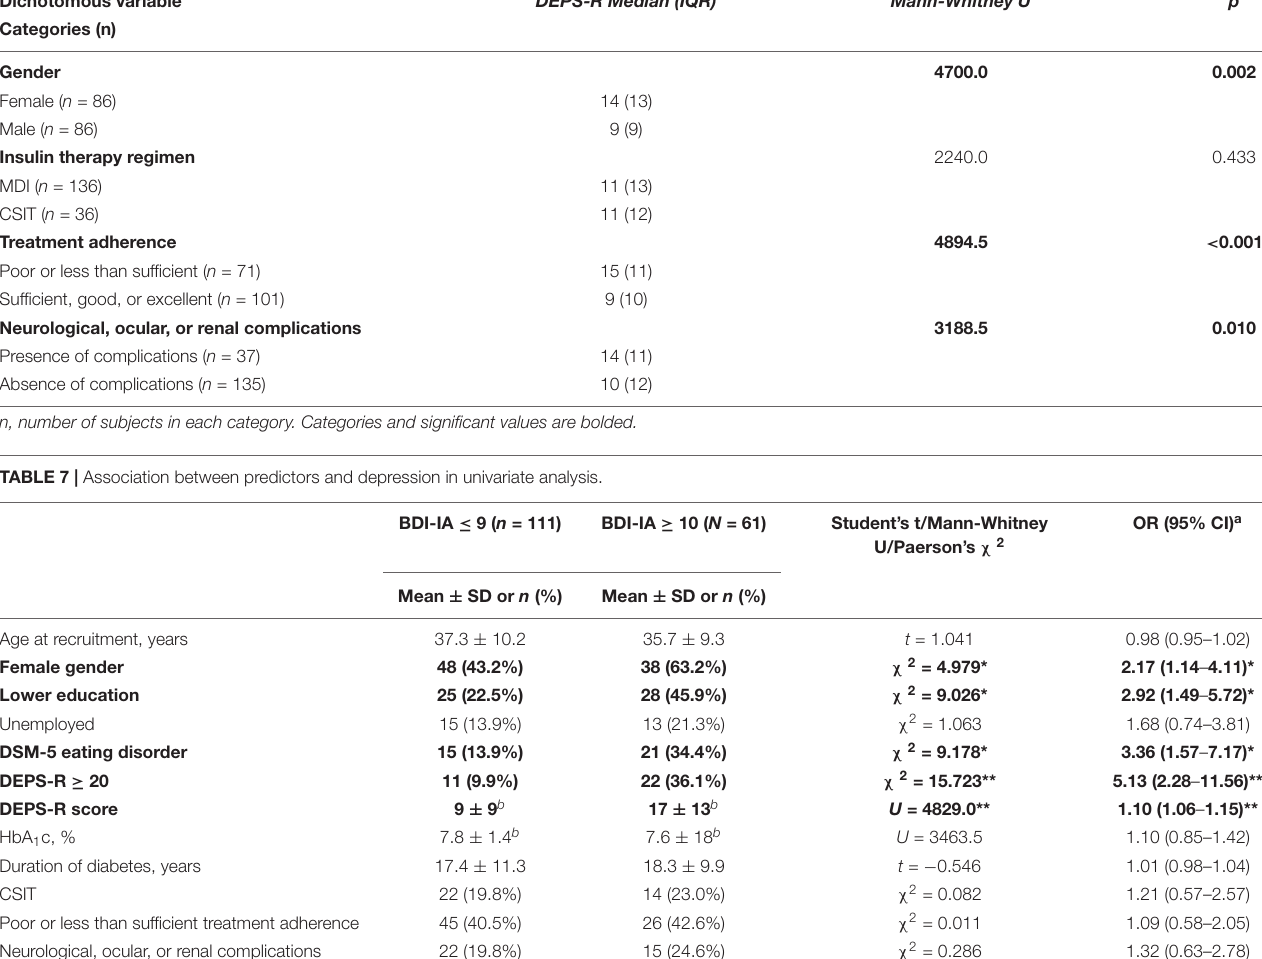
TABLE 6 | Distribution of DEPS-R score in categories of dichotomous variables. Dichotomous variable